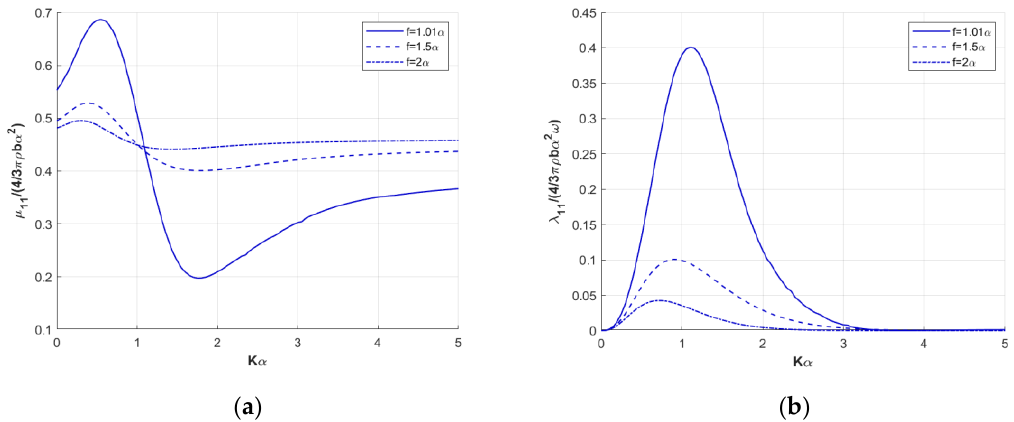
Figure 5. Effect of immersion, 𝑓 , on the normalized surge hydrodynamic coefficients for an oblate Figure 5. E ff ect of immersion, f , on the normalized surge hydrodynamic coe ffi cients for an oblate spheroid of 𝑎/𝑏 = 1.1 : ( a ) Surge added mass; ( b ) Surge hydrodynamic damping. spheroid of a / b = 1.1: ( a ) Surge added mass; ( b ) Surge hydrodynamic